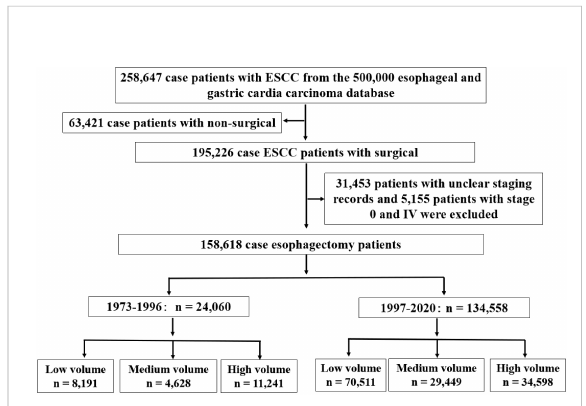
FIGURE 2 Study population selection criteria from database. The study population was selected form the 500,000 esophageal and gastric cardia carcinoma database (1973-2020) and included patients who were diagnosed ESCC from 1973 to 2020. The fi nal cohort sample size was